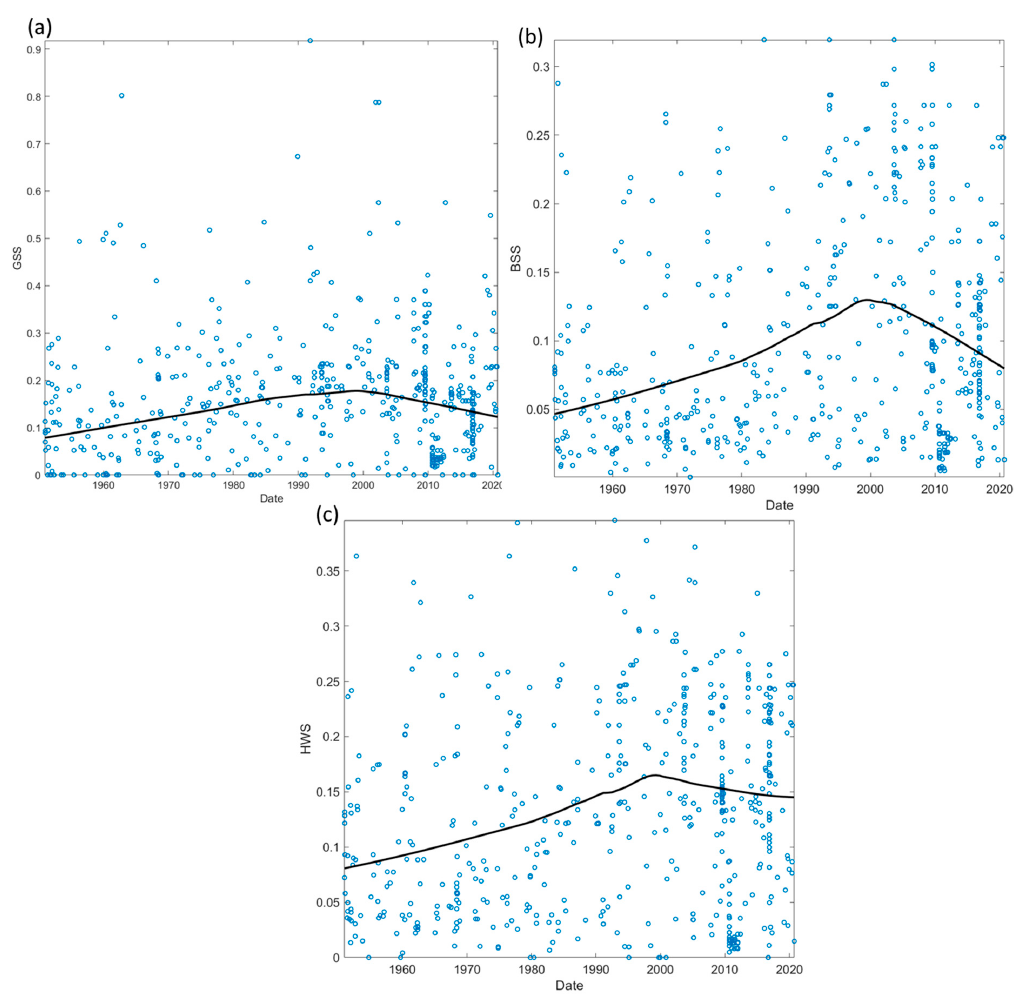
Figure 10. Smoothed scatter plots of ( a ) GSS, ( b ) BSS, and ( c ) HWS strain rate covariates for targeted earthquakes against time from 1951 to 2020.